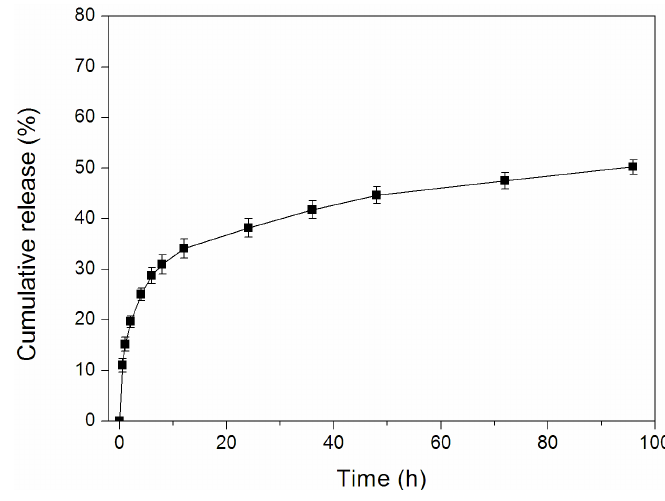
Figure 6. Release profile of Dox from Dex-TOS-3/Dox micelles at 37 °C in phosphate buffer solution (PBS) at pH 7.4.